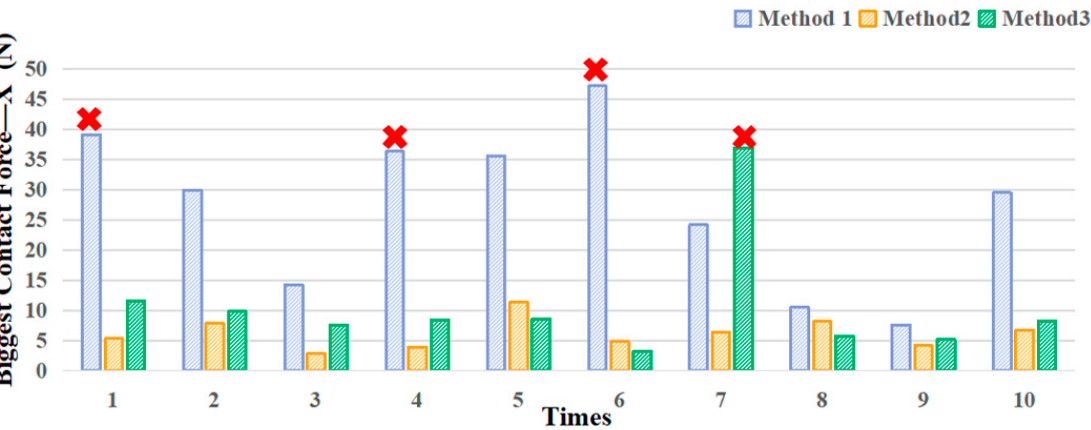
Figure 12. The maximum contact force in the X -axis of the three methods in each experiment.